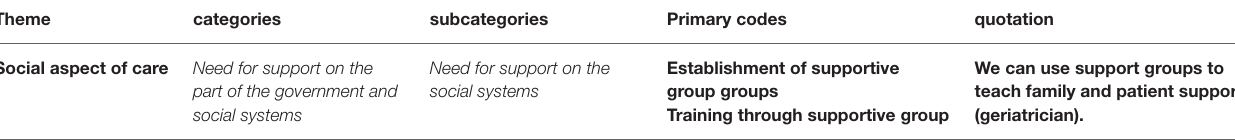
TABLE 3 | An example of data analysis.